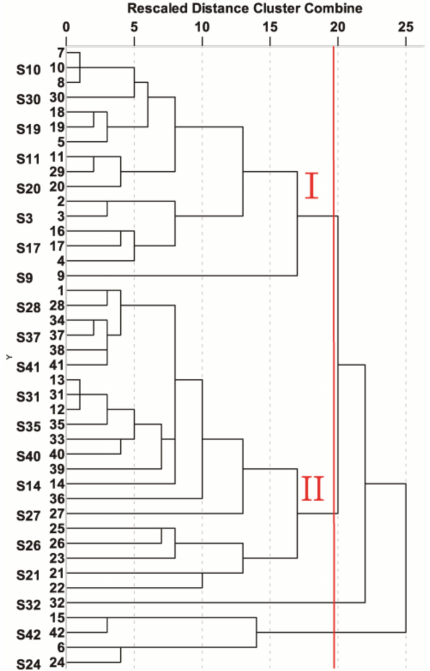
Figure 4. HCA of 42 bark samples of